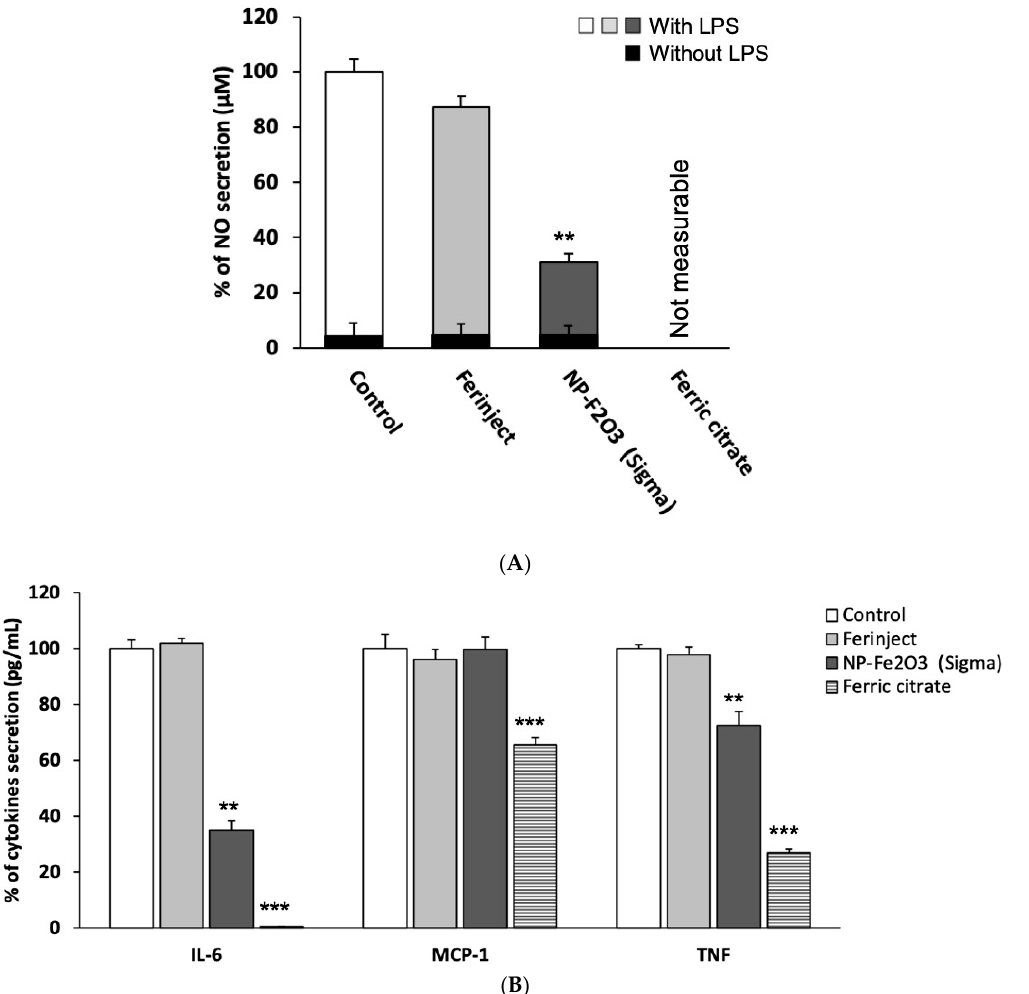
Figure 6. Inflammation ability. Panel ( A ): NO secretion with or without LPS stimulation. Panel ( B ): Secretion of inflammatory cytokines after LPS stimulation. Statistical confidence (student t -test) is indicated as follows ** p ≤ 0.01; *** p ≤ 0.001.